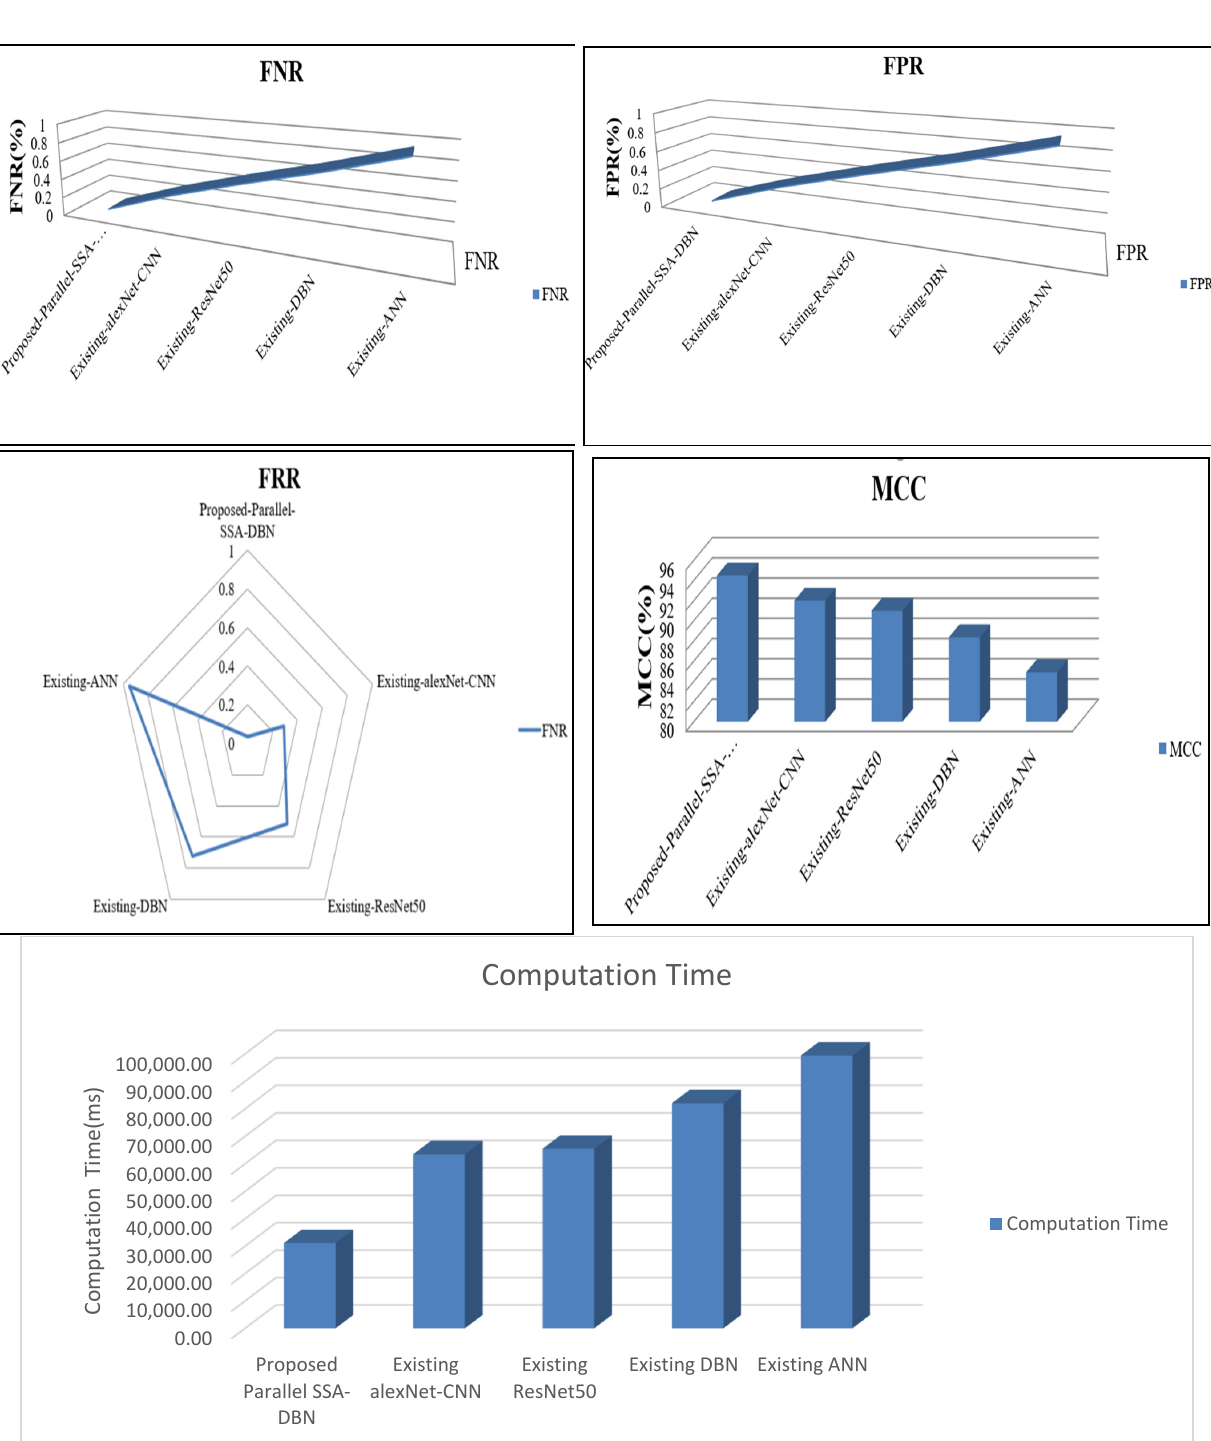
Figure 7. Classification metrics graphical demonstration. Figure 8 demonstrates the fitness vs. iteration for the proposed method, along with the existing methodology. The proposed method tends to perform well for activating the neurons, with a high level of fitness and a low number of iterations. The proposed method